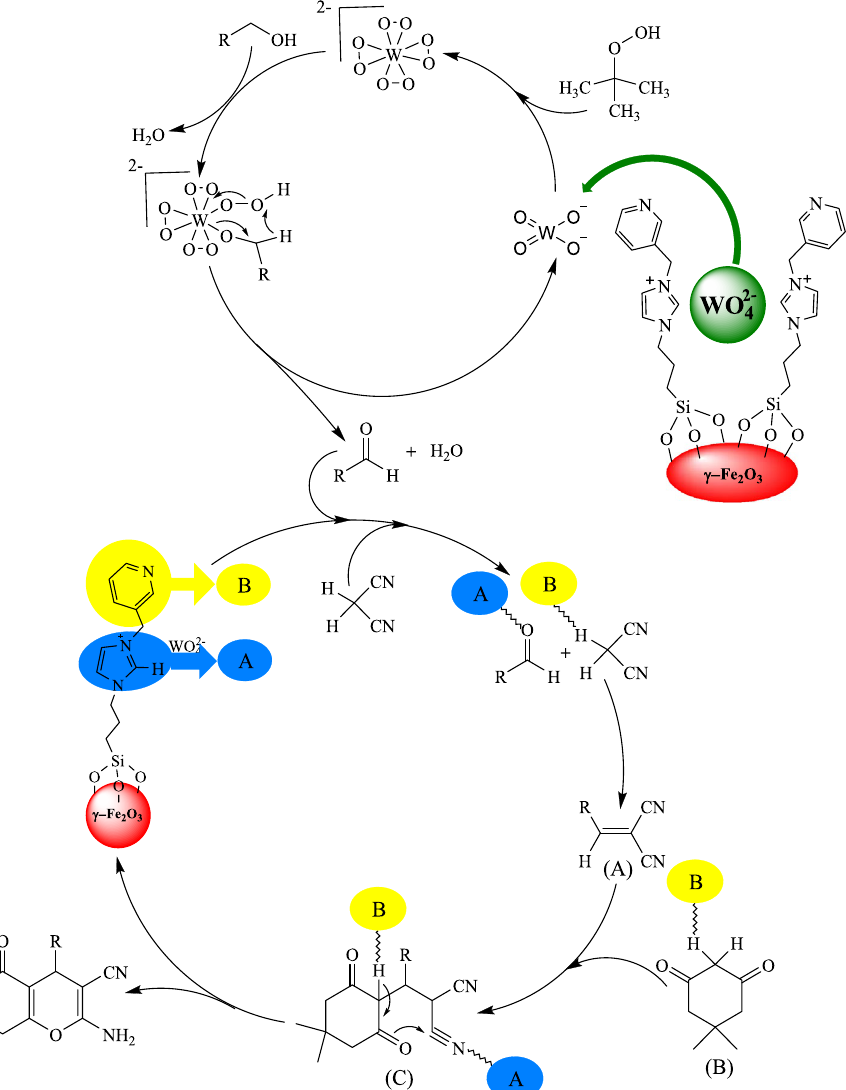
Figure 16. Proposed mechanism pathway for the preparation of functionalized-4 H -chromenes via a multicomponent TOP catalyzed by (γ-Fe 2 O 3 -Im-Py) 2 WO 4 as a multifunctional catalyst.